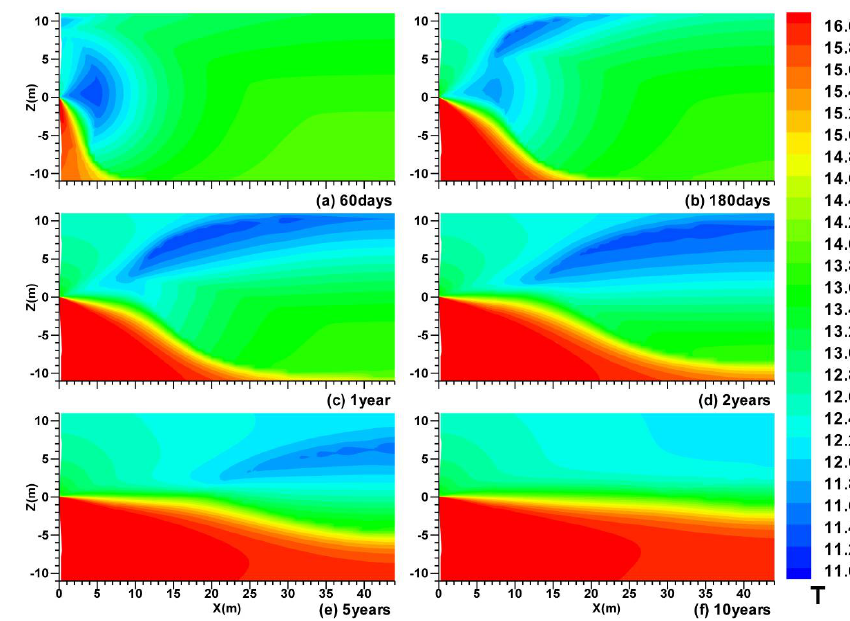
Figure 6. Evolution of spatial distribution of T with permeable boundaries (OB and UB) in Case (i).